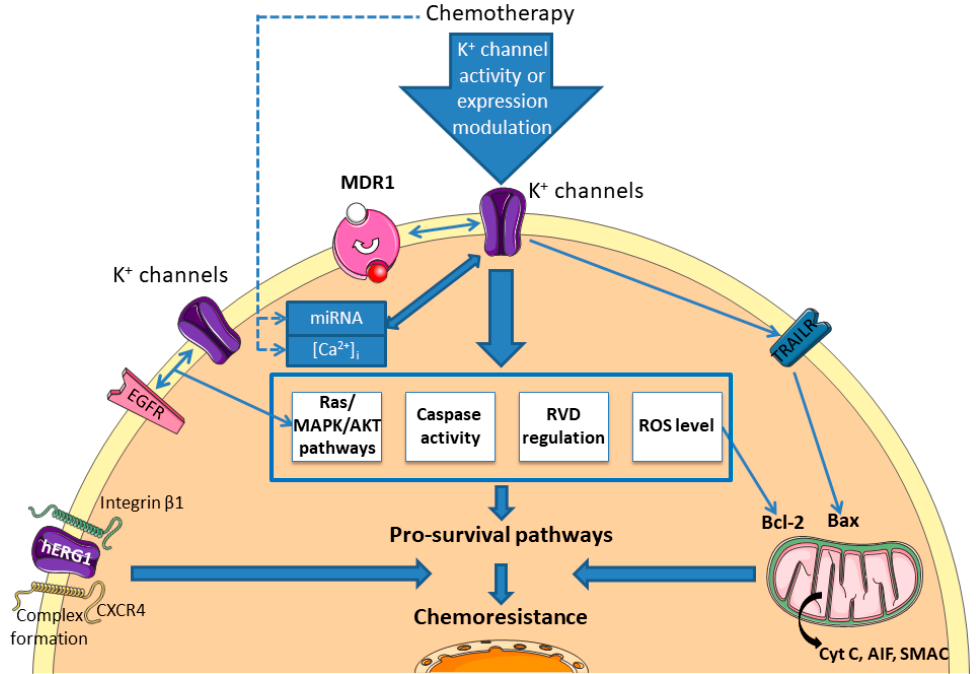
Figure 3. Chemoresistance pathways involving K + channels. K + channels could modulate the sensitivity to different chemotherapies by regulating pro-survival pathways (intrinsec or extrinsec apoptosis pathways, volume regulation, Akt/RAS/MAPK pathways, interacting with receptors or transporters). MDR: Multidrug Resistance Protein; EGFR: Epidermal Growth Factor Receptor; CXCR4: C-X-C Chemokine Receptor type 4; TRAILR: TRAIL Receptor; Cyt C: Cytochrome C; AIF: Apoptosis Inducing Factor; SMAC: Second Mitochondria-derived Activator of Caspases; RVD: Regulatory Volume Decrease.